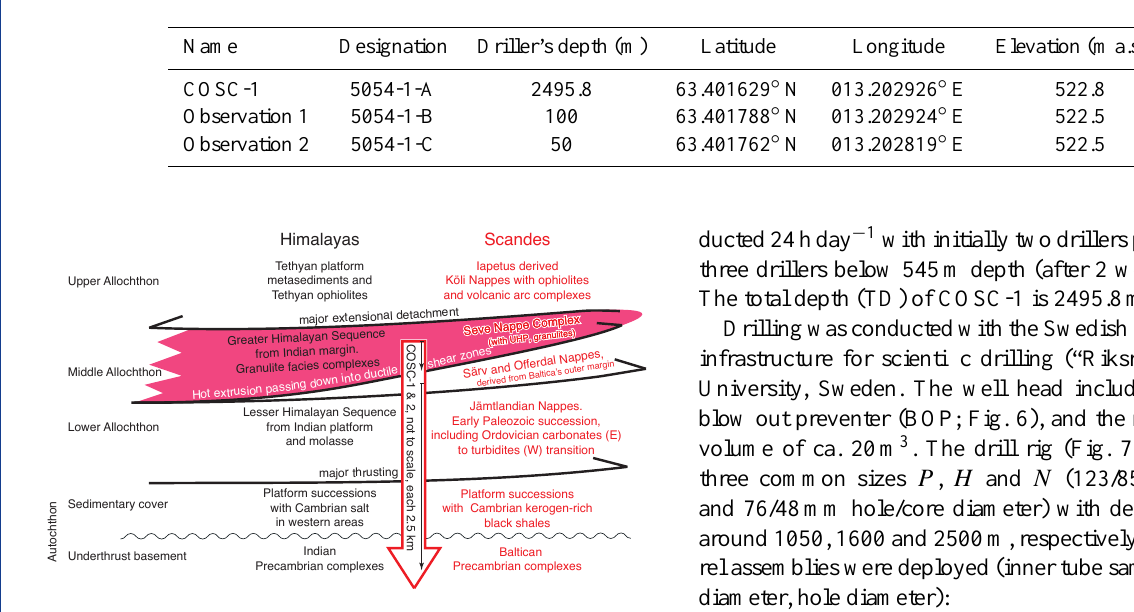
Table 1. Location of the boreholes on the COSC-1 drill site obtained by differential GPS, geodetic datum WGS84 (EPSG:4326).